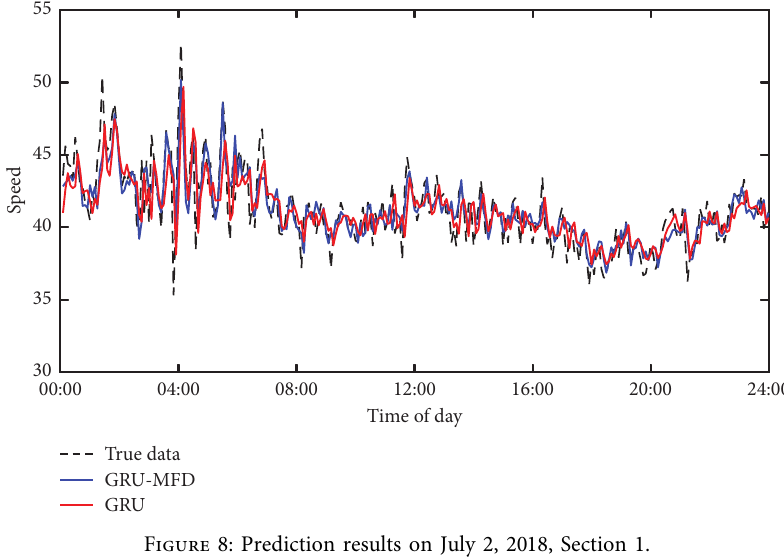
Figure 8: Prediction results on July 2, 2018, Section 1.